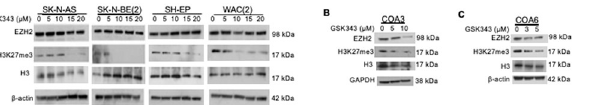
expression was unchanged. (B, C) Similar to long-term passage cell lines, immunoblotting of the human neuroblastoma PDXs demonstrated a decrease in EZH2 expression with the inhibitor GSK343 as well as a decrease in tri-methylation of Histone 3 at Lysine 27, but H3 was not significantly